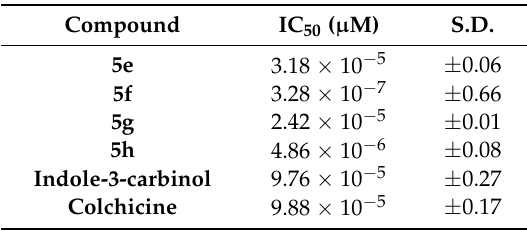
Figure 4. Kinetics of inhibition of tubulin polymerization by 5e – h at 0.25 µ M against colchicine (green) and indole-3-carbinol (yellow) and in the absence of an inhibitor (red). Fluorescence at 450 nm was measured every three seconds over a period of 1 h at 37 ◦ C. Table 4. IC 50 values of 5e – h against tubulin using indol-3-carbinol and colchicine as positive